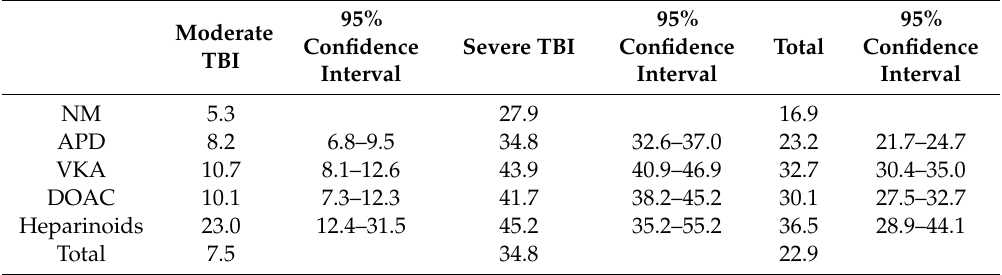
Table 3. Mortality rates and 95% confidence interval for moderate and severe TBI according to preinjury anticoagulation medication intake. No significant differences between the subgroups in relation to age or injury severity where found.